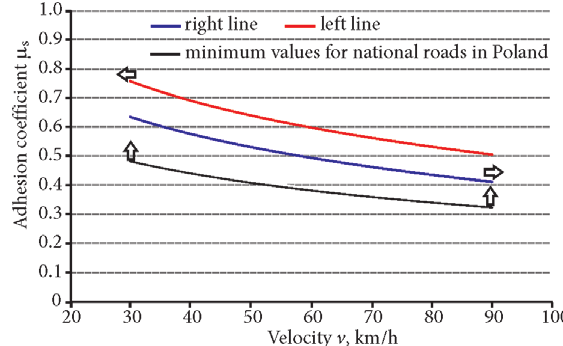
fig. 5. Adhesion coefficient as a function of sliding